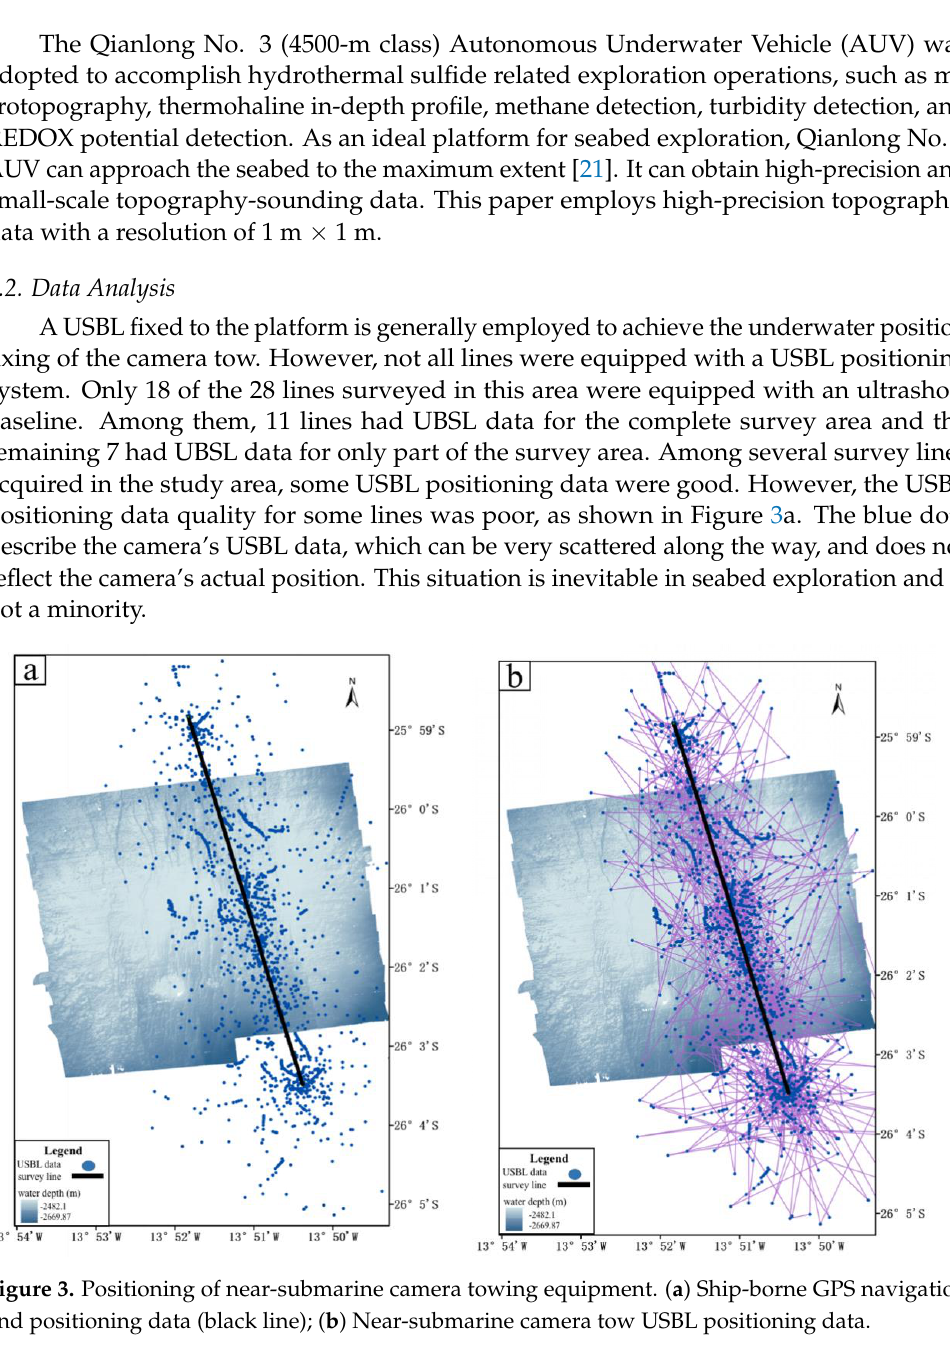
Figure 3. Positioning of near-submarine camera towing equipment. ( a ) Ship-borne GPS navigation and positioning data (black line); ( b ) Near-submarine camera tow USBL positioning data.